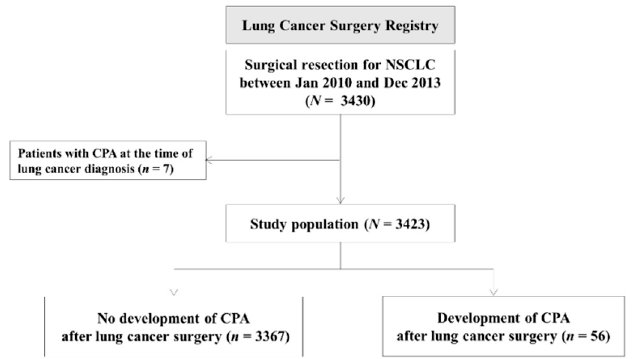
Figure 1. Selection of the study population. NSCLC, non-small-cell lung cancer; CPA, chronic pulmonary aspergillosis.